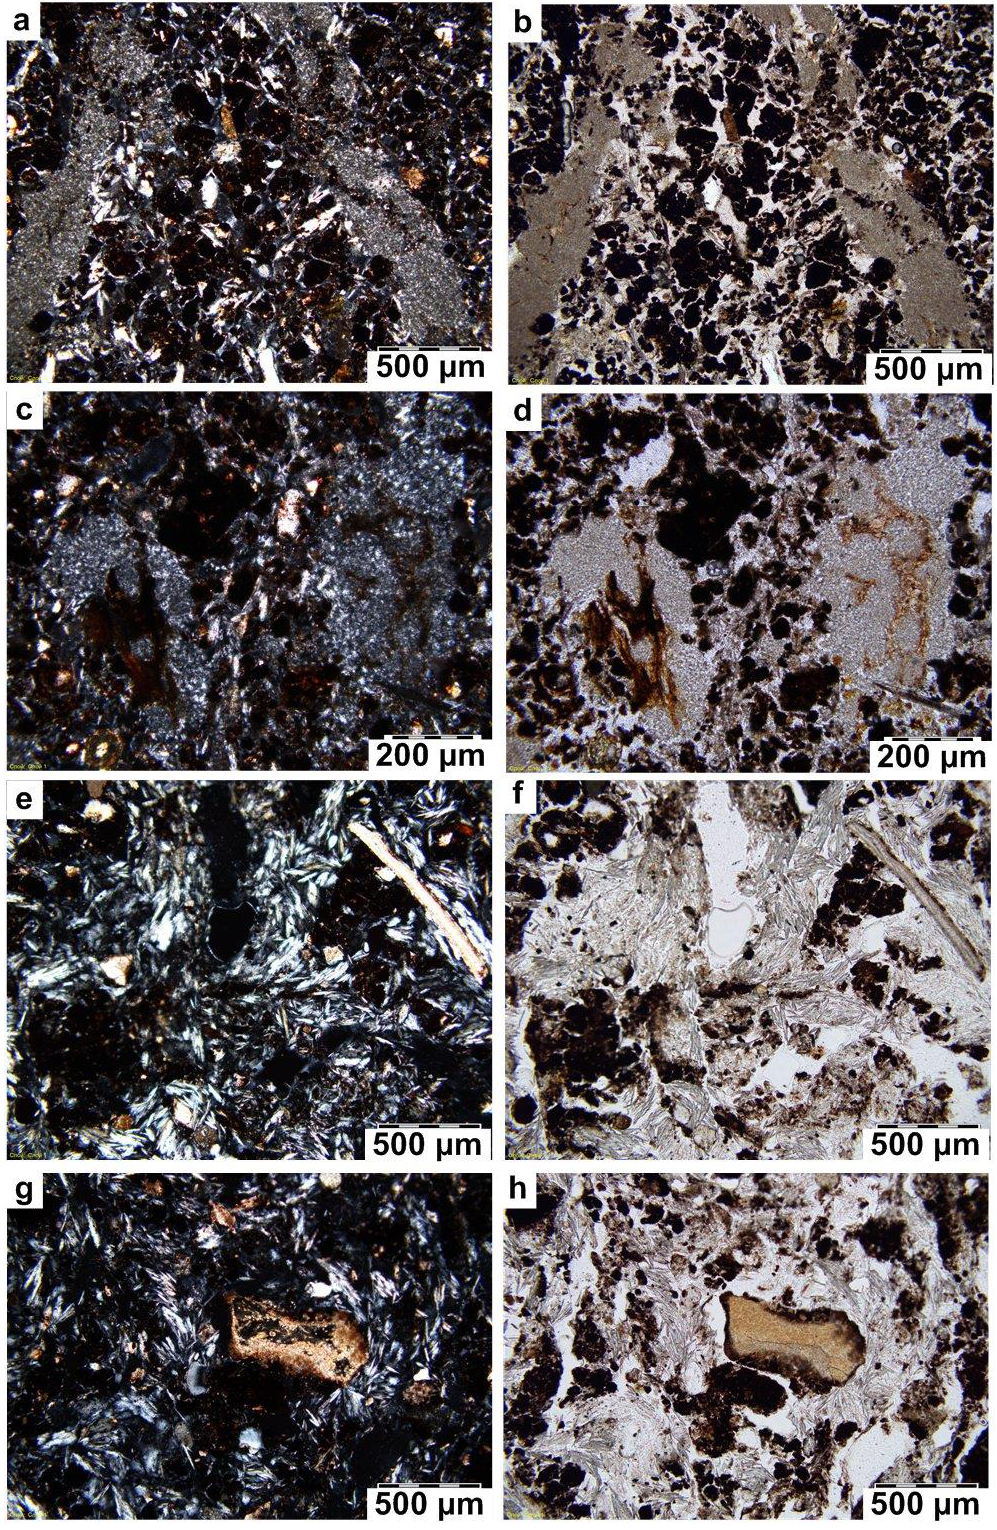
Figure 4. Micromorphological features of soil within the cultural at different depths: 10–20 cm ( a – d ); 60–70 cm ( e – h ). a – d —thick infillings of very dense and small (about 0.05 µm) tabular gypsum crystals in channel pores containing fine residues of plant tissues ( a , c —XPL; b , d —PPL); e , f —loose continuous infillings composed of lenticular and acicular gypsum crystals; g, h—particles of bones with the carbonates ( e , g —XPL; f , h —PPL).